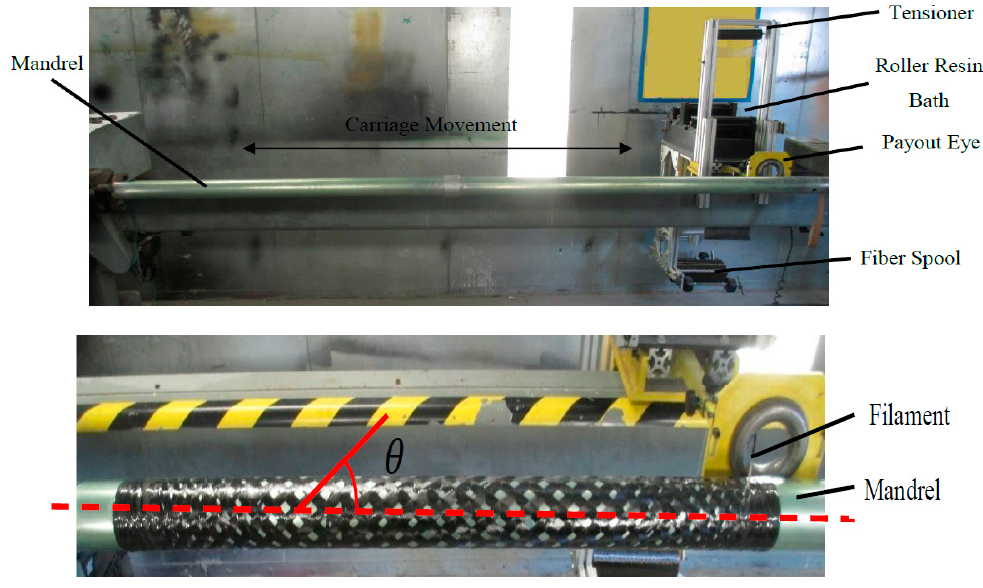
Figure 4. Filament winding method.